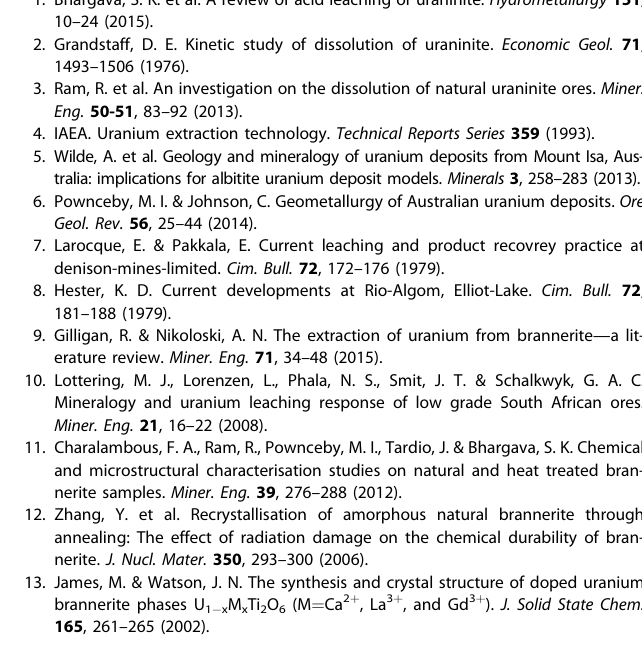
where k (g/(m 2 d)) is the rate constant, E A (kJ/mol) is the apparent activation energy of the overall reaction, R is the gas constant, and T is the absolute temperature. (H 3 O + ) is the activity of proton, and n is the partial order of the reaction related to the proton. The rate law parameters k , E A and n were fi tted using the entire set of R L (U) data obtained either in the presence or in absence of Fe(III) in solution using the JMP V14 statistical software. The nonlinear regression was done using the analytic Gauss-Newton algorithm. The pH values were calculated from the molalities of the prepared H 2 SO 4 solutions with the geochemical speciation software PHREEQC 49 associated with the Thermochimie SIT V9 thermodynamic database 50,51 . In this database, the log K° (298K) associated to the protonation equilibrium H + + SO 4 2 − # HSO 4 − and the enthalpy of reaction reach 1.98 and 22.44kJ/mol, respectively. The molar to molal conversion was performed using the densities of 0.1mol/L, 1 and 2mol/L H 2 SO 4 solutions at the corresponding temperature. The density of acid solutions were calculated using the expression developed by Novotny and Sohnel 52 . Then, the activity corrections were performed using the Speci fi c Interaction Theory (SIT) as implemented in PHREEQC. The proton activities of the various solutions calculated using PHREEQC software are summarized in Supplementary Table S1.